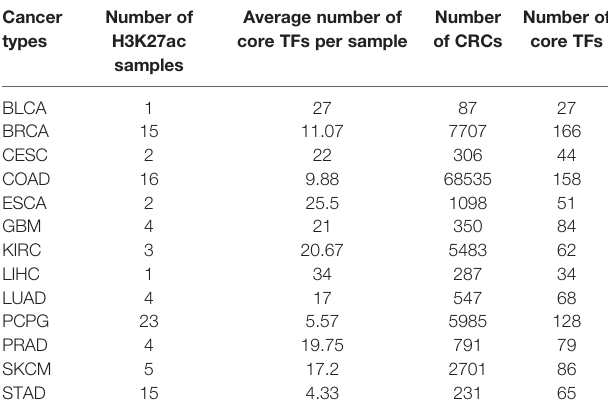
TABLE 1 | Data summary in the Cancer